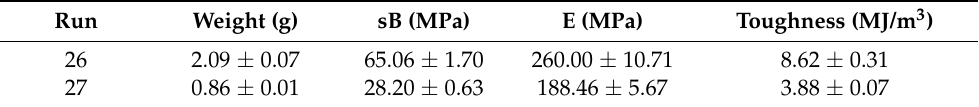
Table 9. Average and standard deviation values of measured responses for weight, tensile strength, tensile modulus of elasticity, and tensile toughness, for the confirmation runs.